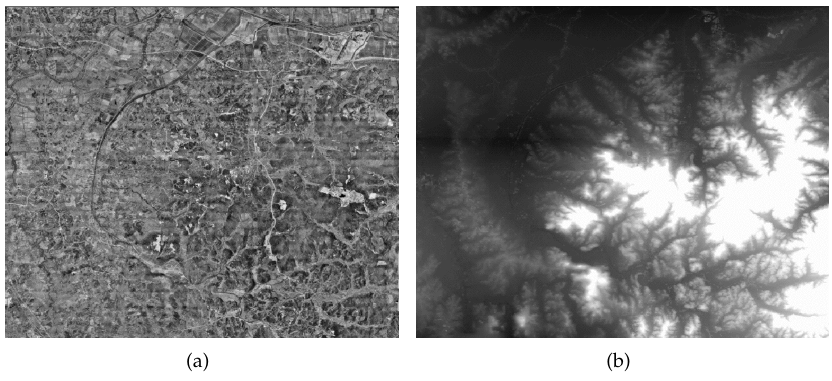
Figure 5. The reference data for image simulation: ( a ) DOM and ( b )